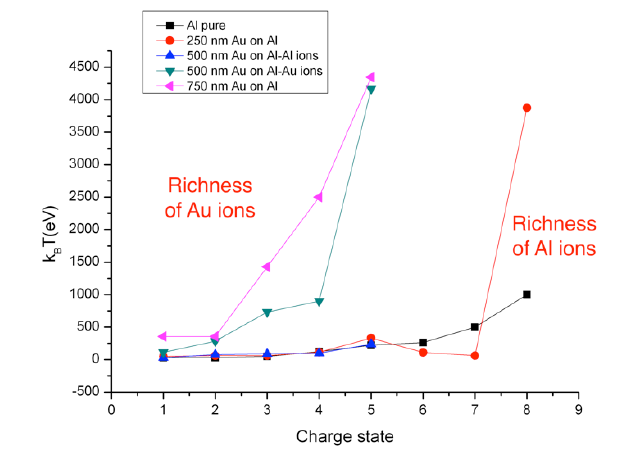
Fig. 6. Plasma temperature obtained from fit operation using CBS